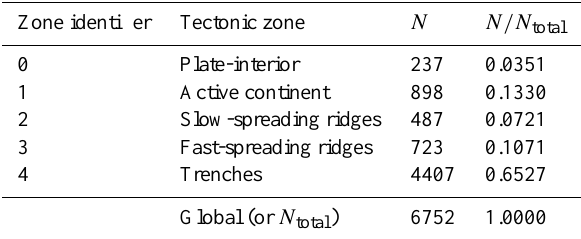
Table 1. Tectonic zone identifier, tectonic zone and the number of earthquakes considered for M w > 5 . 6 and depth < 70km from